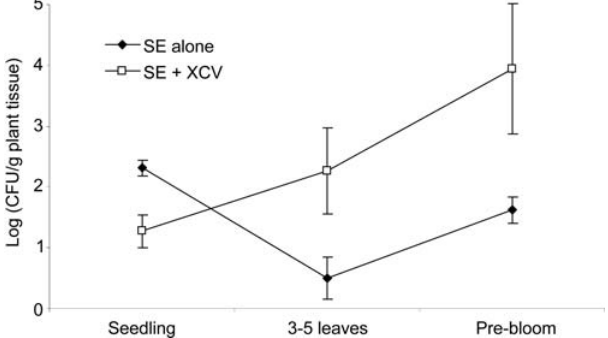
Figure 2. Average Salmonellaenterica populations in the tomato phyllosphere. S. enterica populations are from plants with (white square) or without (black diamond) inoculation of tomato seed with Xanthomonas campestris pv. vesicatoria. Autoclaved soil was irrigated with S. enterica 24 h prior to seed sowing. Averages from two experiments were calculated from log transformed data and error bars represent standard deviations.